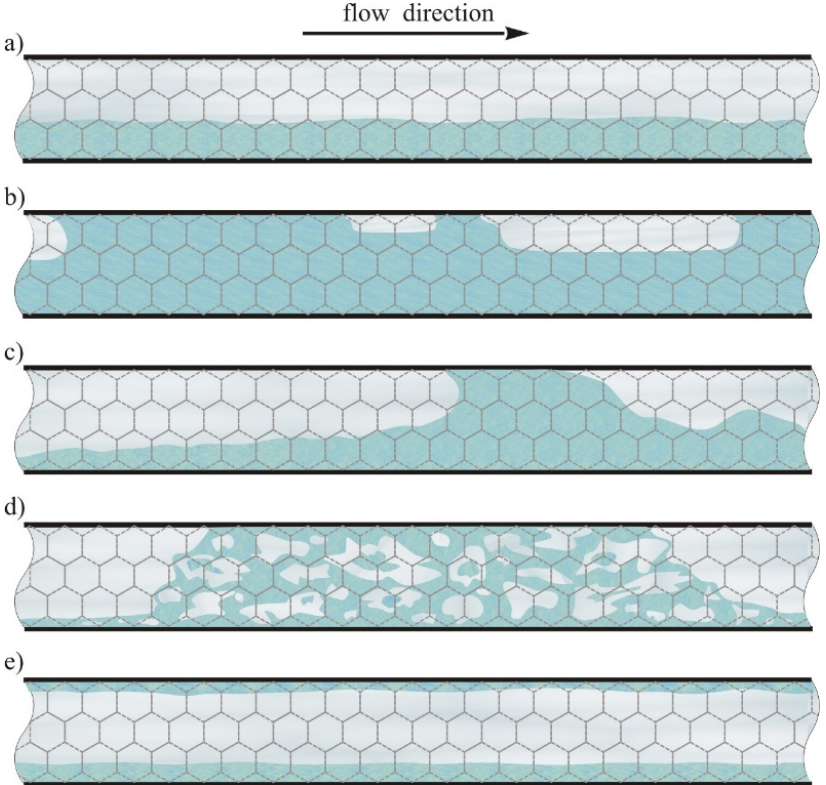
Figure 3. Gas − liquid flow patterns accompanying flow through metal foams: ( a ) stratified, ( b ) plug, ( c ) slug, ( d ) churn, ( e ) annular.